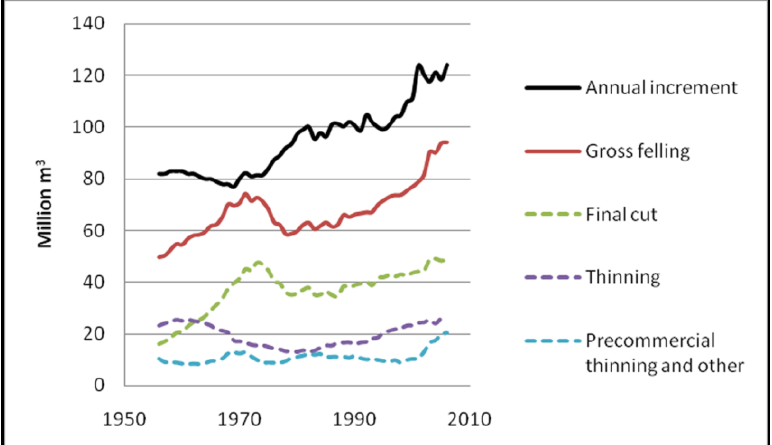
Figure 7. Annual increment and gross felling in Sweden from 1956 to 2006. Data are five-year annual averages ( i.e. , data for 2006 are the means for 2004–2008)